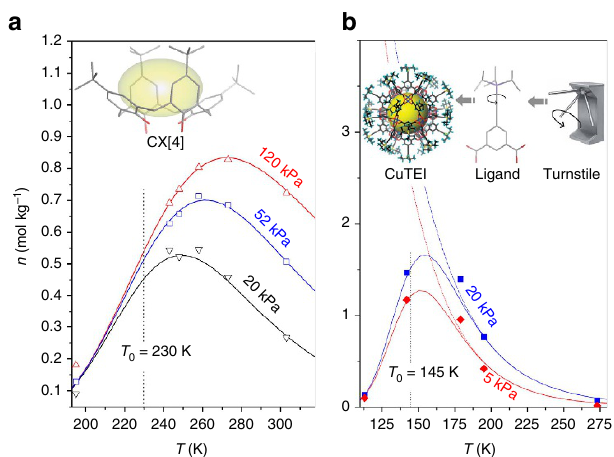
Figure 5 | Demonstration of temperature regulated guest admission on supramolecular hosts and MOFs. ( a ) Typical bell-shaped isobars for the adsorption of CH 4 on p - t -butylcalix[4]arene showing good agreement between the experimental data (points) and the LJM model (solid curves). A threshold admission temperature of 230K was determined by the model’s regression. Inset: molecular structure of p - t -butylcalix[4]arene showing the accessibility of its basket-shaped cavity is kept by four thermally responsive t - butyl groups. ( b ) Representative adsorption isobars for CH 4 on CuTEI, a MOF nanocage whose ligand 5-((triisopropylsilyl)ethynyl)isophthalic acid (TEI) provides a turnstile-type configuration. Symbols denote experimental data, solid curves the fitting by LJM-Toth model, and dashed curves the inevitable overestimation of the guest uptake using conventional physisorption models. Inset: illustration of the turnstile type pore keeping group in CuTEI (the cage structure of the CuTEI was adapted from Fig. 1 in Chem. Commun . 46, 7352–7354 (2010) with permission from The Royal Society of Chemistry). For clarity, less than 1/5 th of the data points used in the regression are presented in a , b . The full data set is available in the Supplementary Table 8.